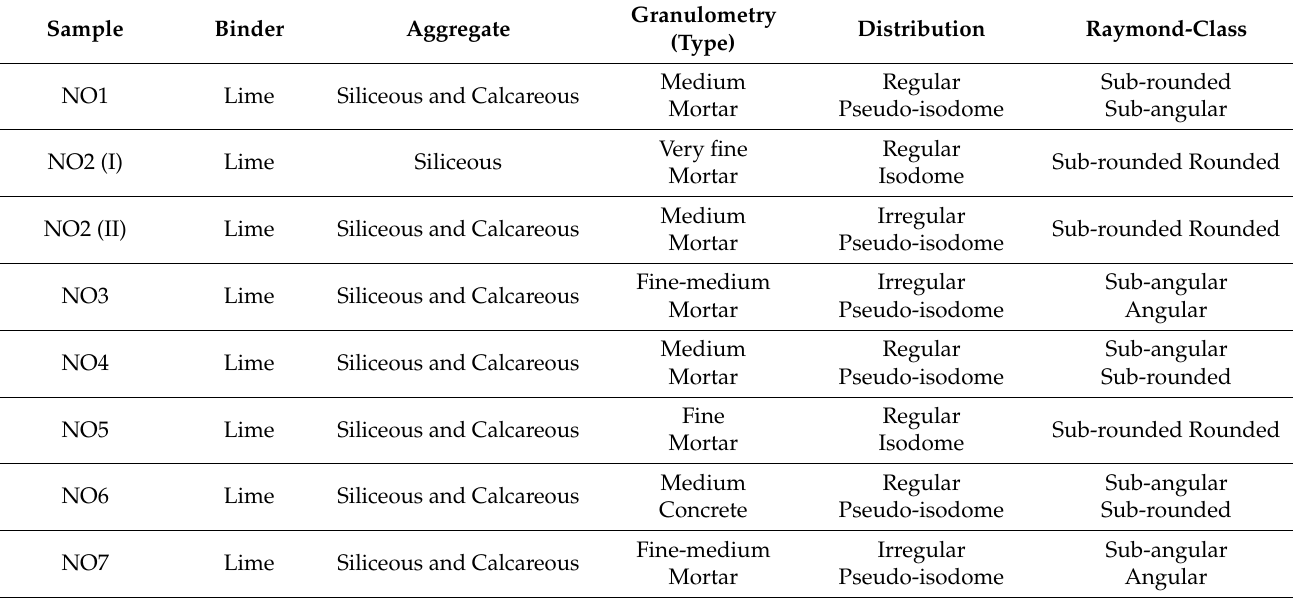
Table 2. Granulometry results.